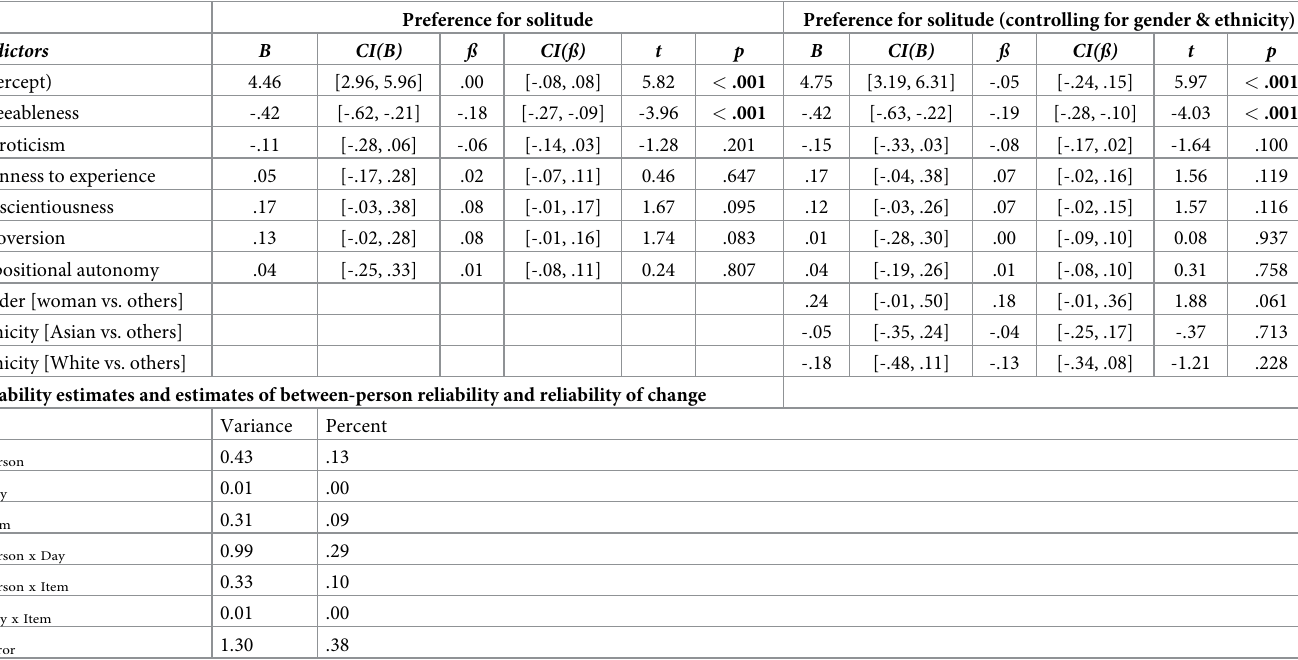
Table 4. Random-intercept models that include introversion, dispositional autonomy, and all other big-five traits, predicting daily preference for solitude (Study